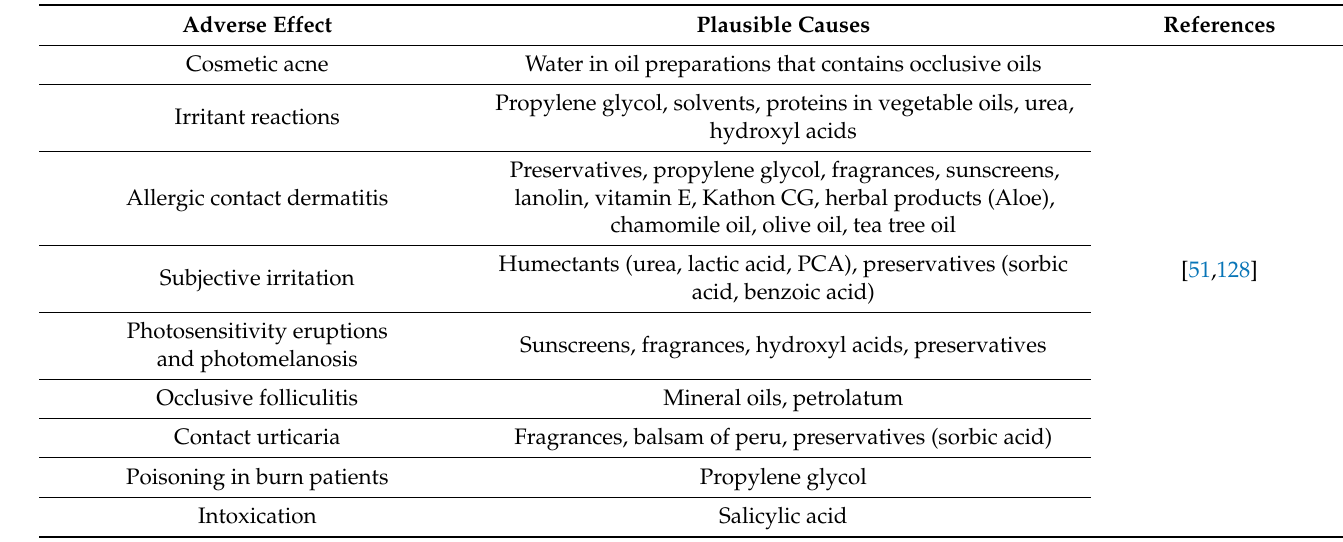
Table 3. Adverse effects of